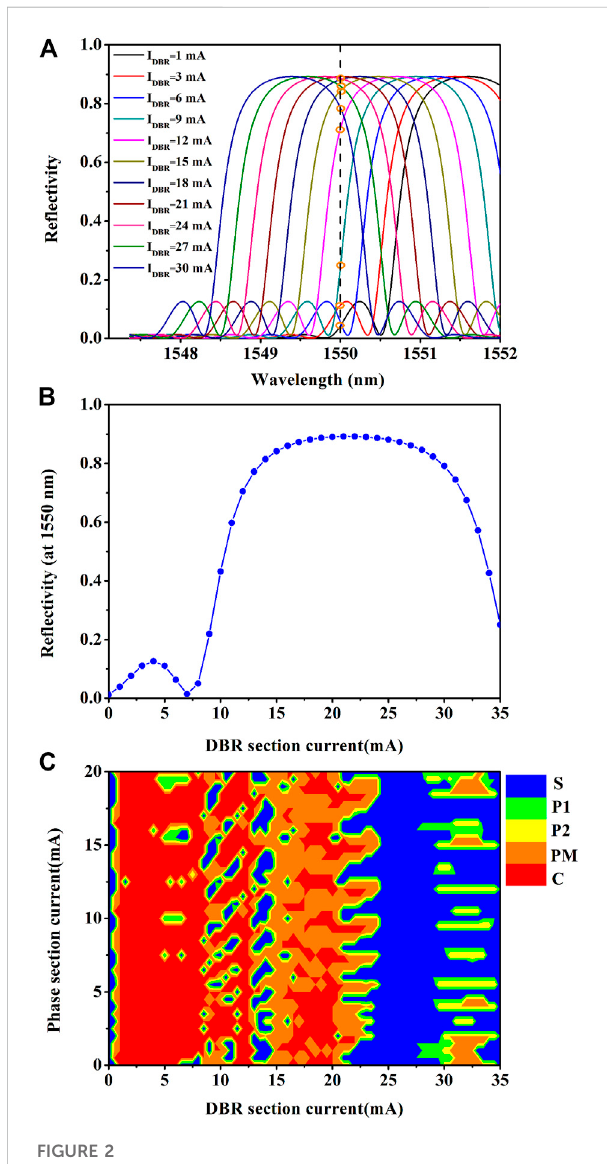
FIGURE 2 (A) Re fl ection spectra of the DBR grating under different I DBR . (B) Re fl ectivity of the DBR grating at 1,550.0 nm as functions of I DBR . (C) Map of dynamic states in the parameter space of I DBR and I Phase for I DFB = 50.0 mA. Blue, green, yellow, orange, and red areas correspond to steady state (S), single-period (P1) oscillation, doubling period (P2) oscillation, multi-period (PM) oscillation, and chaos (C) ,